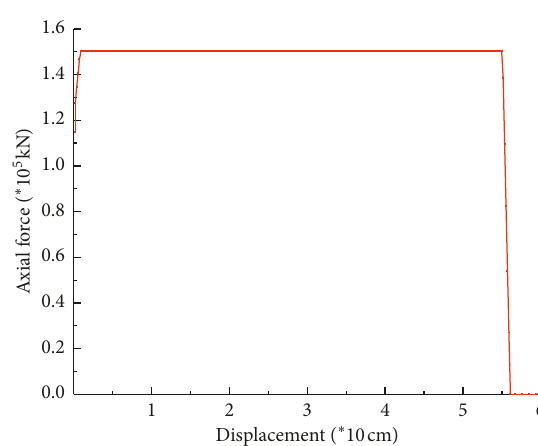
Figure 16: The static tensile mechanical